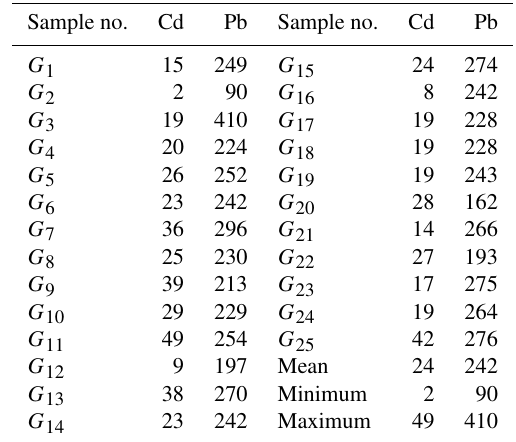
Table 3. Cd and Pb concentrations (µgL − 1 ) in the studied ground- water